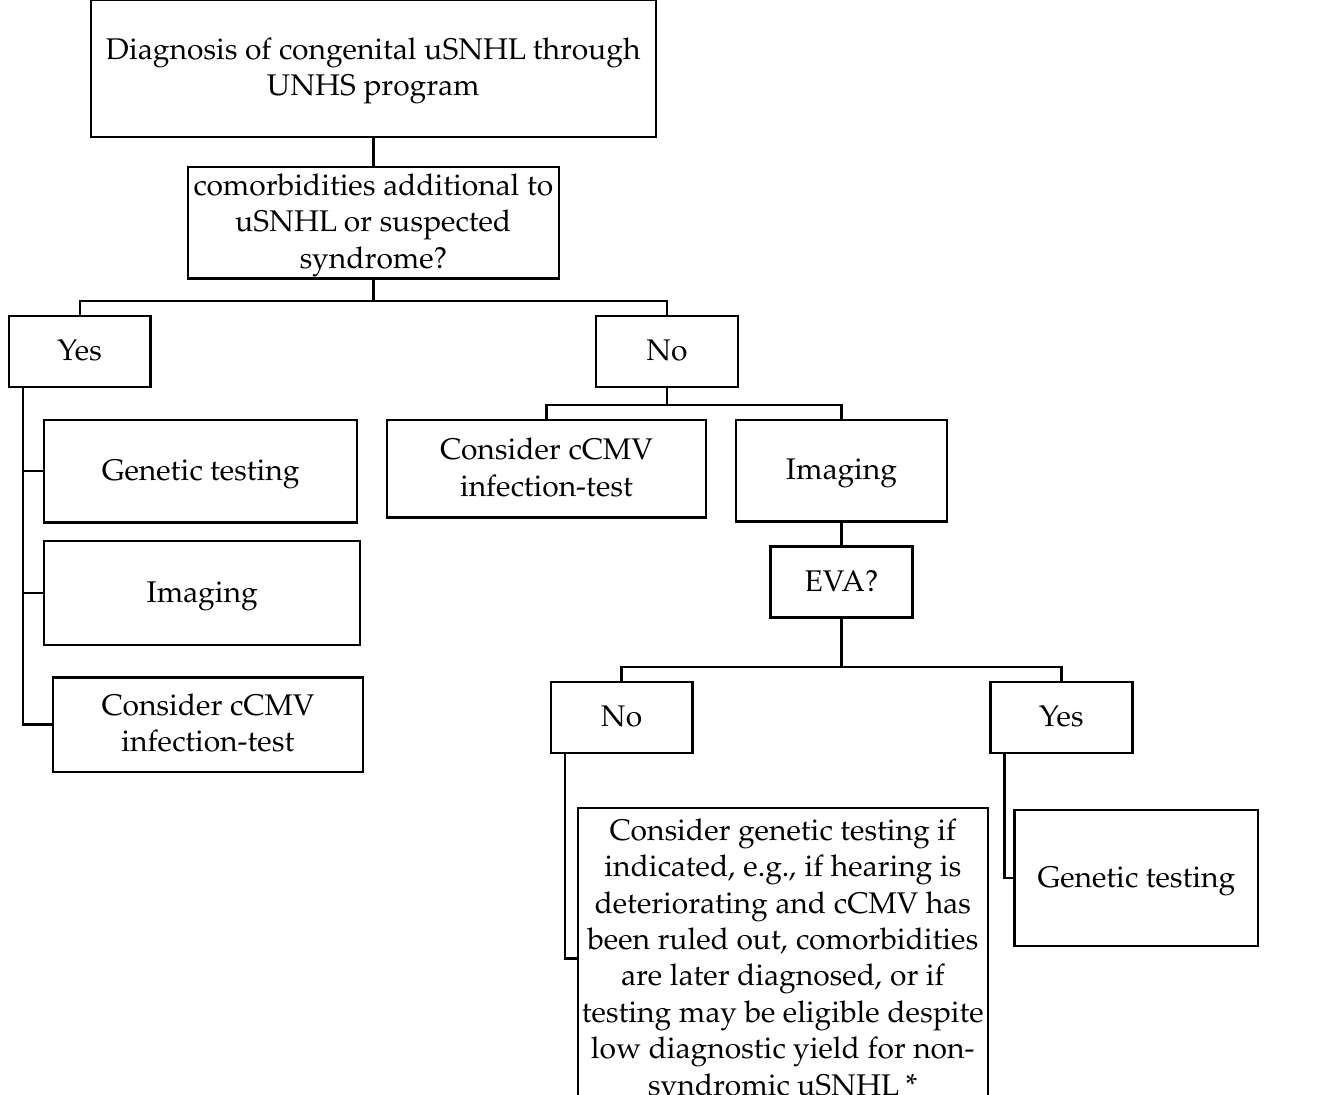
Figure 1. Current suggestion for clinical etiologic investigation of congenital unilateral sensorineural hearing loss (uSNHL, comprising 25% of SNHL found in universal newborn hearing screening (UNHS) programs) based on the results of this first prospective study of consecutively recruited infants from a UNHS program, and previous research. * Genetic testing diagnostic yield for alleged non-syndromic uSNHL ≈ 7% here (1/14, GJB2/connexin 26). cCMV = congenital cytomegalovirus; EVA = enlarged vestibular aqueduct; uSNHL = unilateral sensorineural hearing loss; UNHS = universal newborn hearing screening.